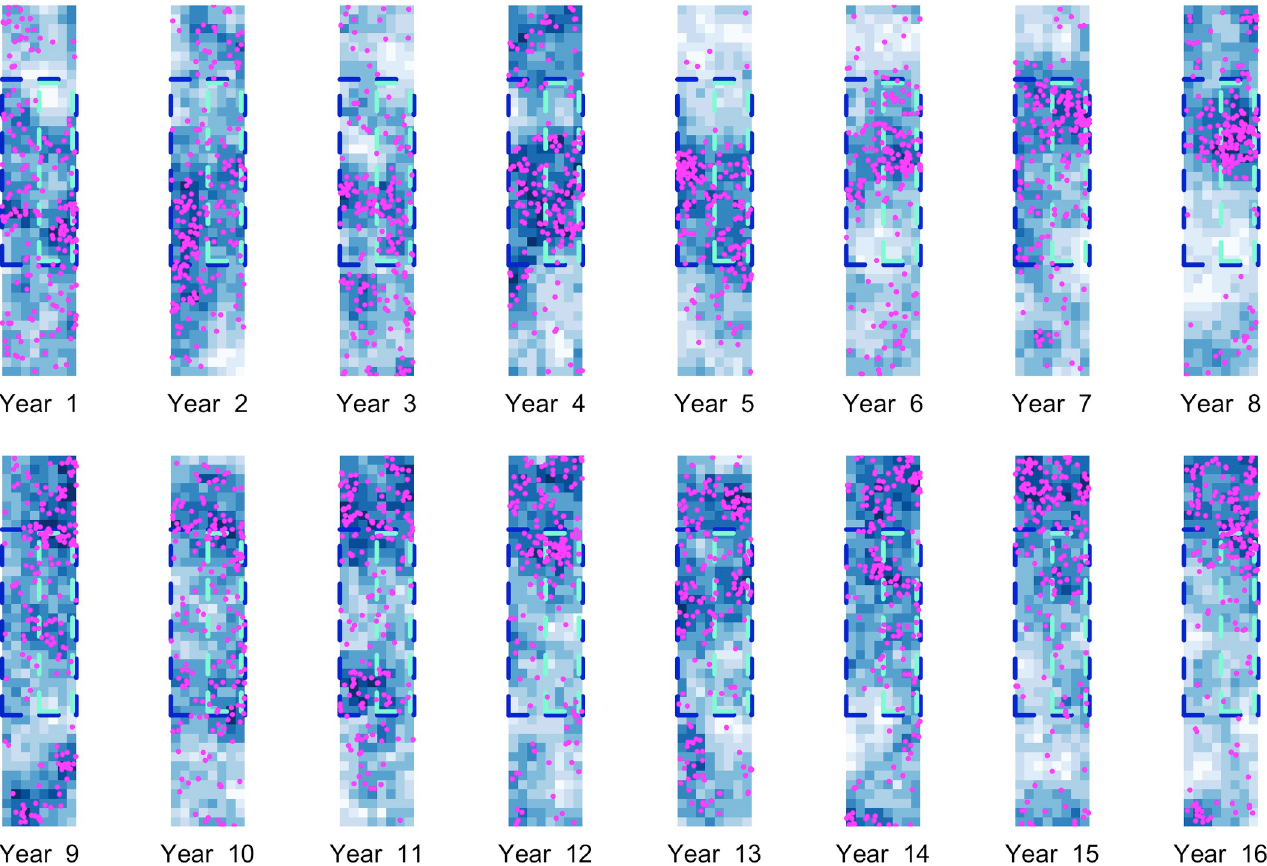
Fig 1. 16 representations of a spatially autocorrelated habitat index used to simulate broad-scale population distributions. The sequence shown here is used for the shifting habitat scenarios (Scenarios B and D), with a relatively high proportion of habitat in the survey region in the first 8 years, and a relatively low proportion in the second 8 years. Darker blues indicate more suitable habitat. Magenta points indicate the distribution of a stable population (as in Scenario B) as a function of relative habitat suitability. The survey region is delineated by dark blue dashed lines; the small boat study area (i.e. the area within which target cells are selected) is shown by the cyan dashed